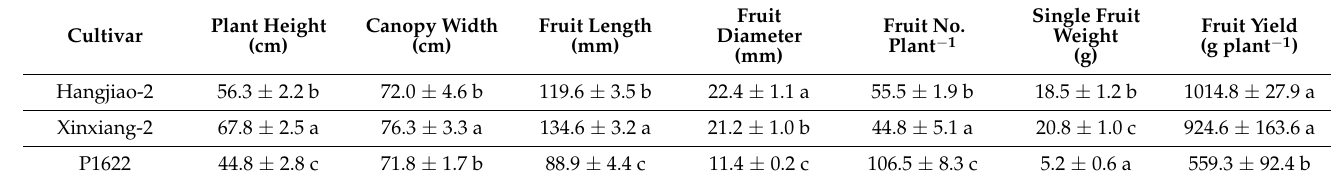
Table 1. Phenotypic characteristics of three pepper cultivars used in this